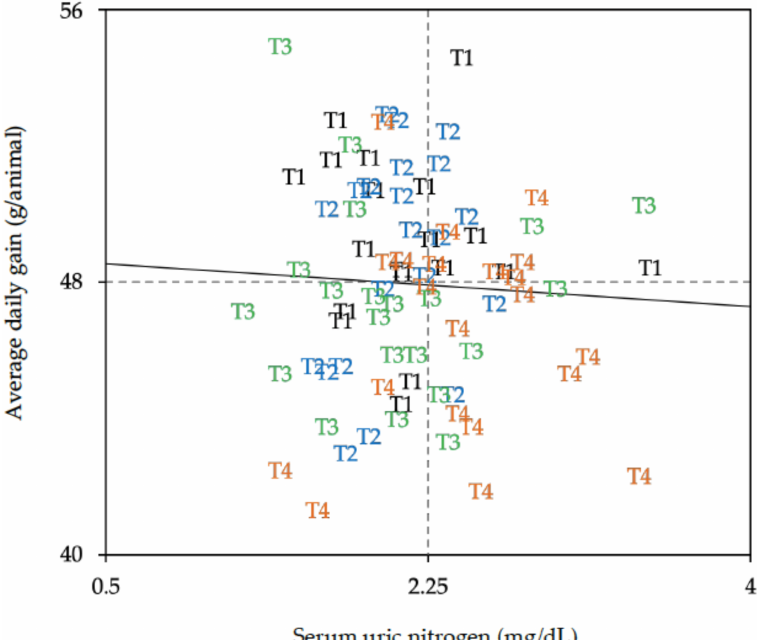
Figure 1. Relationship between animal’s serum uric nitrogen (SUN), when fed the different experi- mental diets varying in crude protein, as well as valine and arginine to lysine ratios (T1 to T4), and individual average daily weight gain during the last period of the grower phase (day 28 to 35) in broilers ( n = 21 animals per treatment). T1: 20% crude protein content, valine/lysine ratio (0.80) and arginine/lysine ratio (1.05) formulated according to current recommendations; T2: 18% crude protein content and valine/lysine ratio (0.80) and arginine/lysine ratio (1.05) formulated according to current recommendations; T3: 18% crude protein content, below-required valine/lysine ratio (0.70) and arginine/lysine ratio (1.05) formulated according to current recommendations; T4: 18% crude protein content, below-required arginine/lysine ratio (0.92) and valine/lysine ratio (0.80) formulated according to current